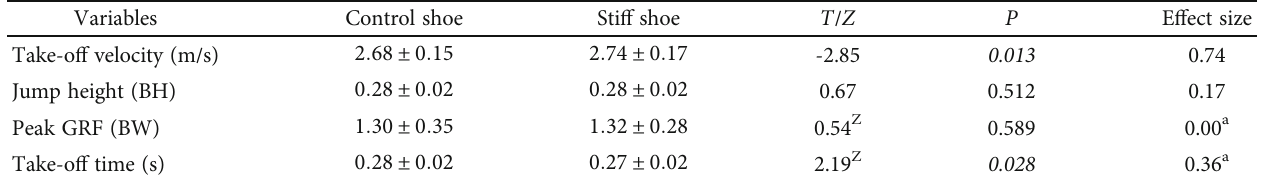
Table 2: Jump performance and GRF variables ( mean ± SD